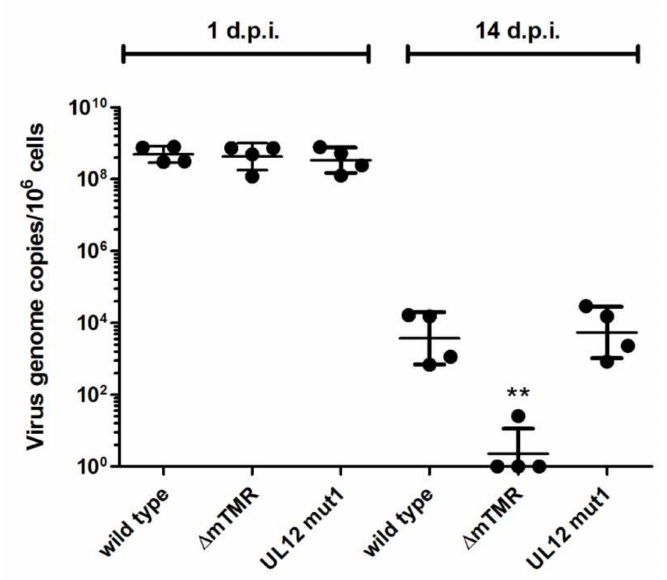
Figure 4. Viral genome maintenance in CU91 T cells infected with UL12 mut1. CU91 T cells were infected with different MDV mutants and infected cells cultured for 14 days. Samples were taken for qPCR analysis on day 1 and day 14. The plots show the mean level of virus genome copies per million cells from four independent experiments (each experiment is depicted by a single dot). Statistics were performed using the Kruskal–Wallis test (** p < 0,01). d.p.i: days